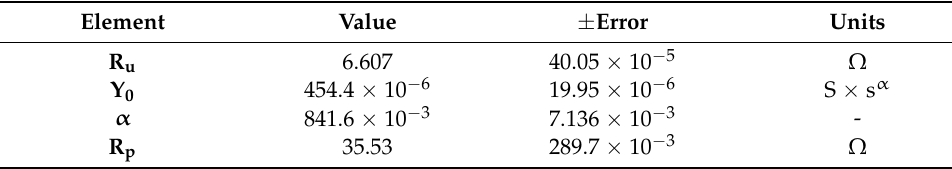
Table 3. Value of equivalent circuit components for uncoated steel.